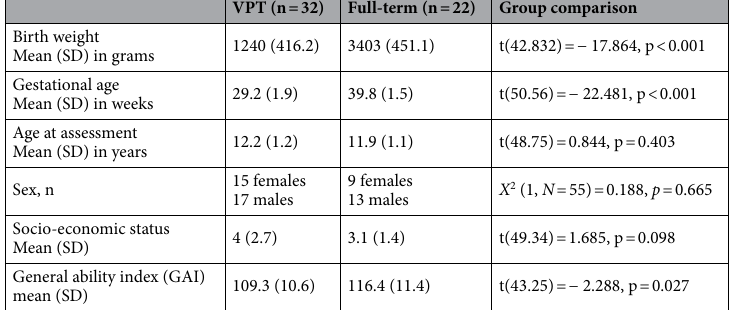
Table 1. Neonatal and demographic characteristics of the VPT and full-term participants. For VPT young adolescent, age correspond to the age at pre-MBI assessment. General ability index (GAI) was evaluated using the Wechsler Intelligence Scale for Children—4th Edition, WISC-IV 27 as a measure of general intellectual functioning (mean for the general population = 100, standard-deviation = 15). Socioeconomic status of the parents was estimated using the Largo scale, a validated 12-point score based on maternal education and paternal occupation 70 . Higher socio-economic status scores reflect lower socio-economic level. Independent- sample t-test or Chi-square as appropriate were used to compare the preterm and full-term participants.